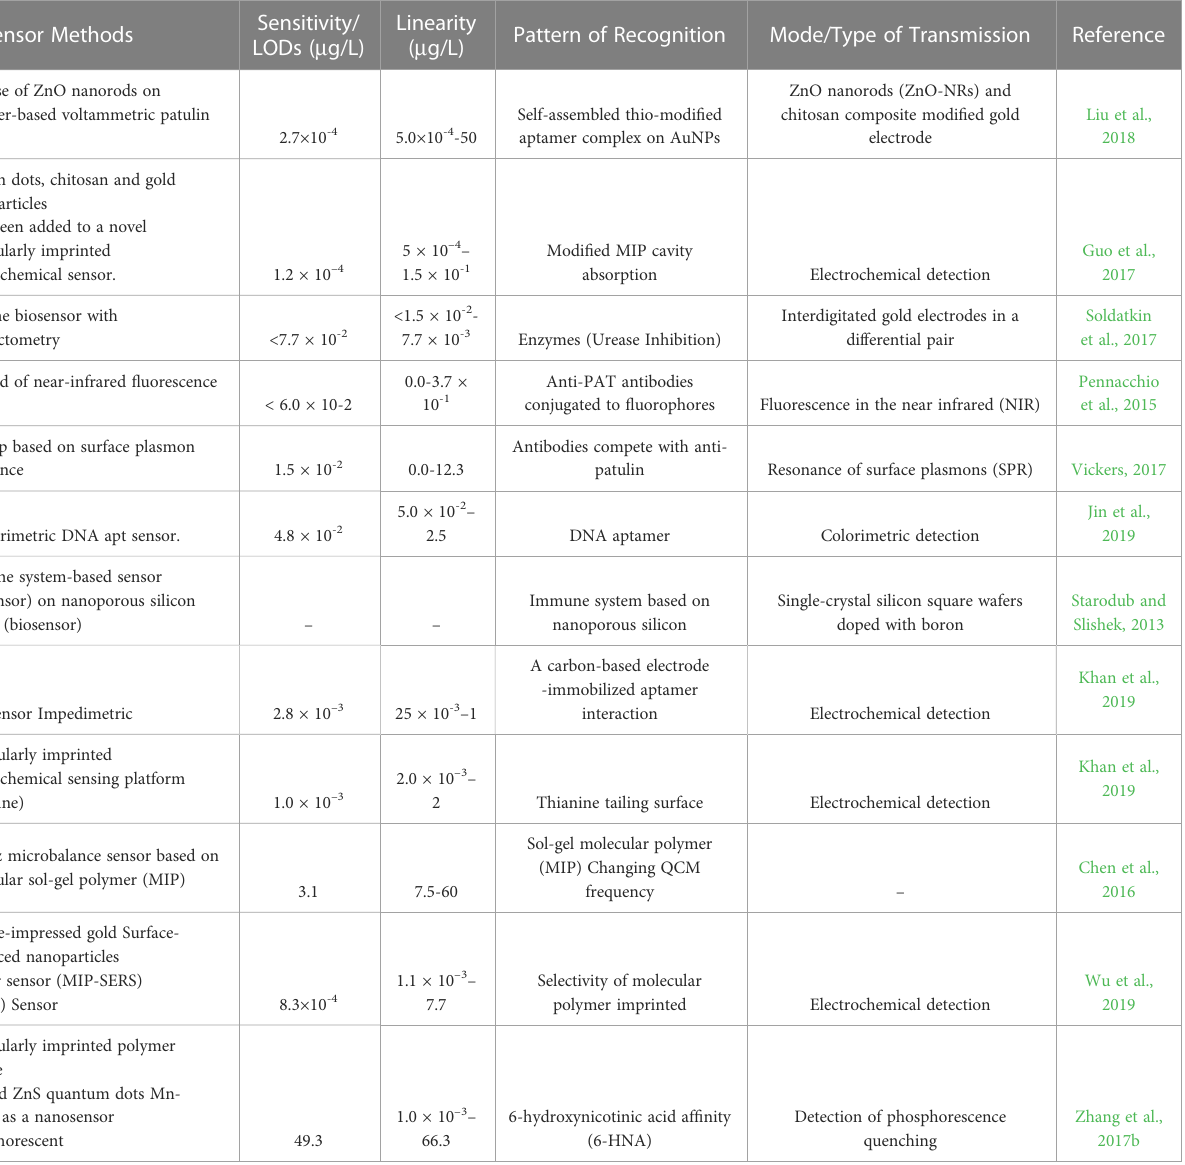
TABLE 2 Methods for detecting PAT using